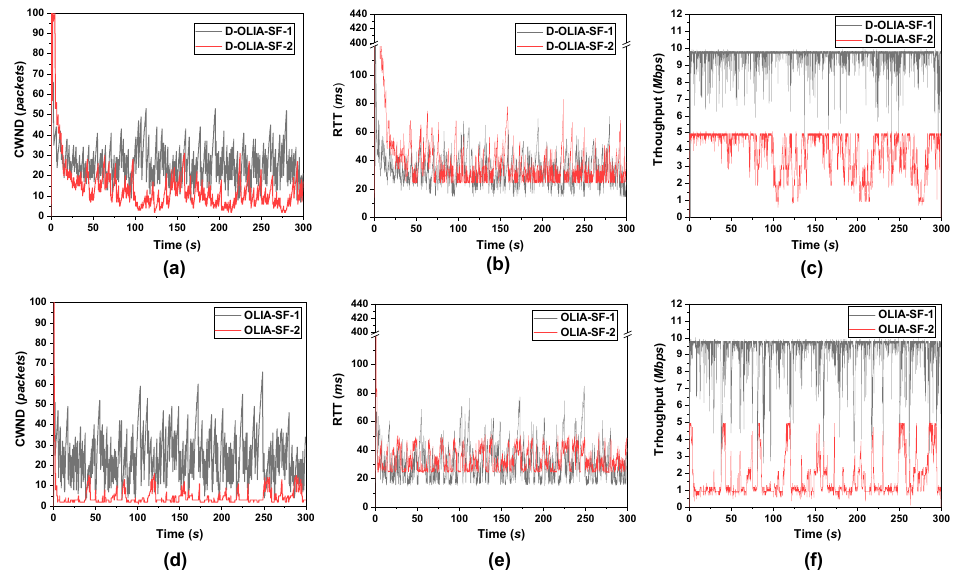
Figure 4. Performance analysis of the considered MPTCP-CCAs for Scenario #1 in terms of CWND, RTT, and throughput for ( a–c ) D-OLIA and ( d–f ) OLIA.